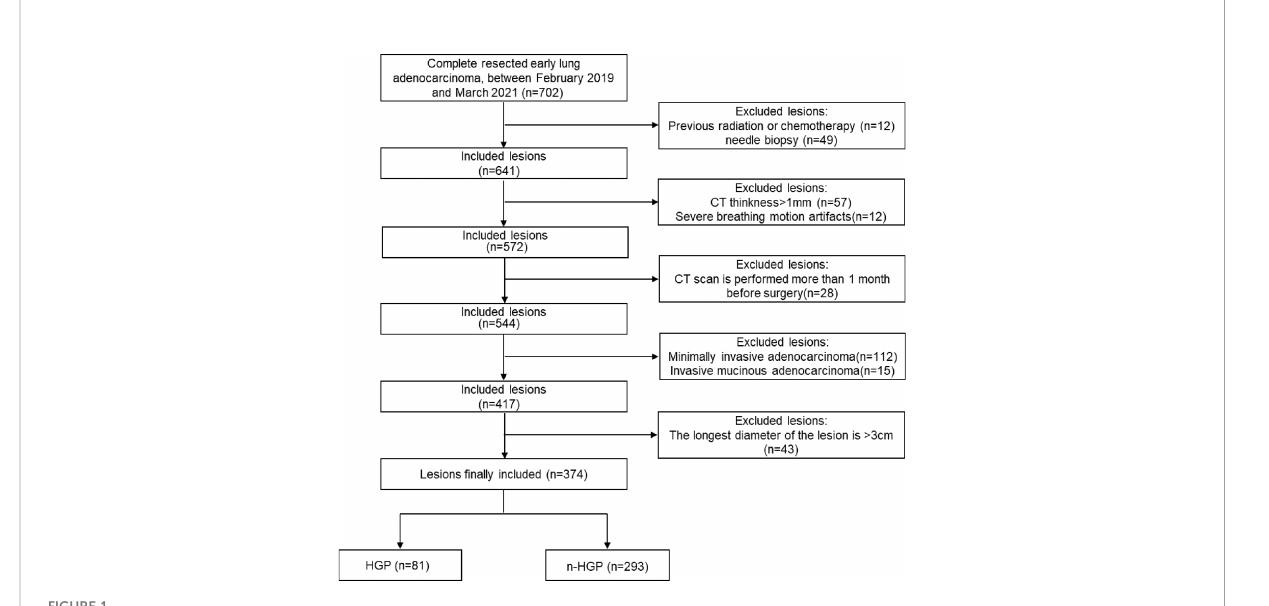
FIGURE 1 Schedule of patient